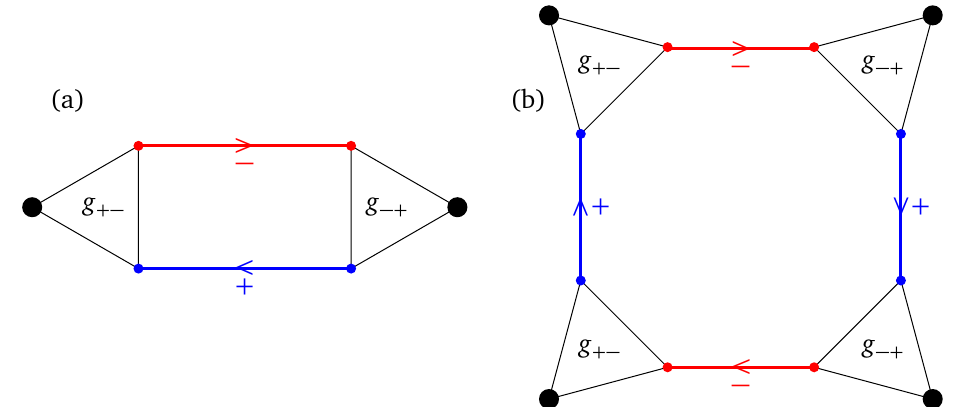
Figure 3: (a) Diagram for the renormalization of the phonon frequency. The black dots rep- resent external phonon lines, the red and blue lines denote the electronic Green’s functions G ± in the band basis, and the triangles are the electron-phonon coupling. (b) Fourth order